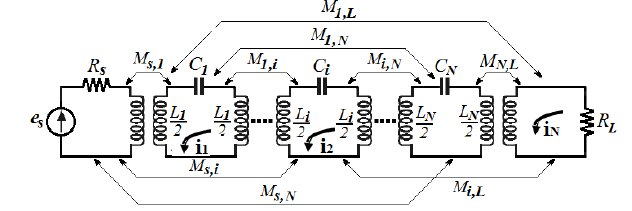
FIGURE 1. Multi-coupled series-resonator bandpass prototype.